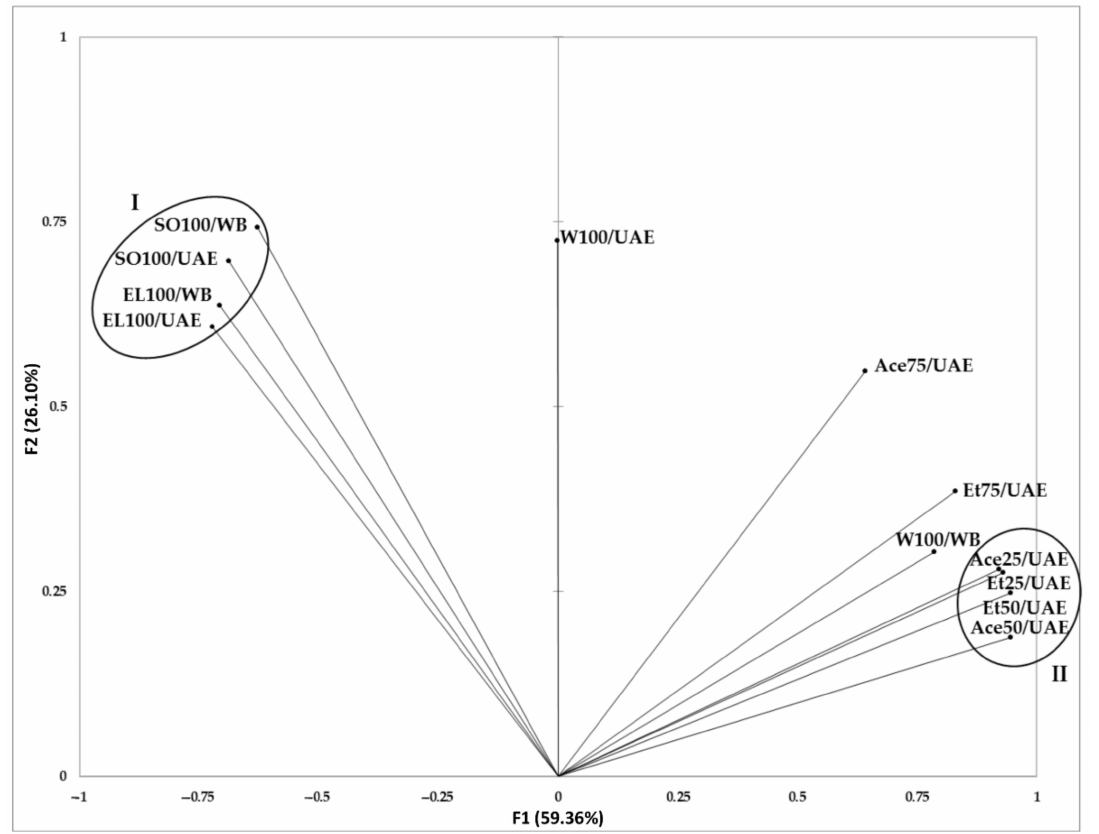
Figure 2. Principal component analysis (PCA) model of extraction methods used in the study, on the basis of bioactivity and microbial quality of the obtained